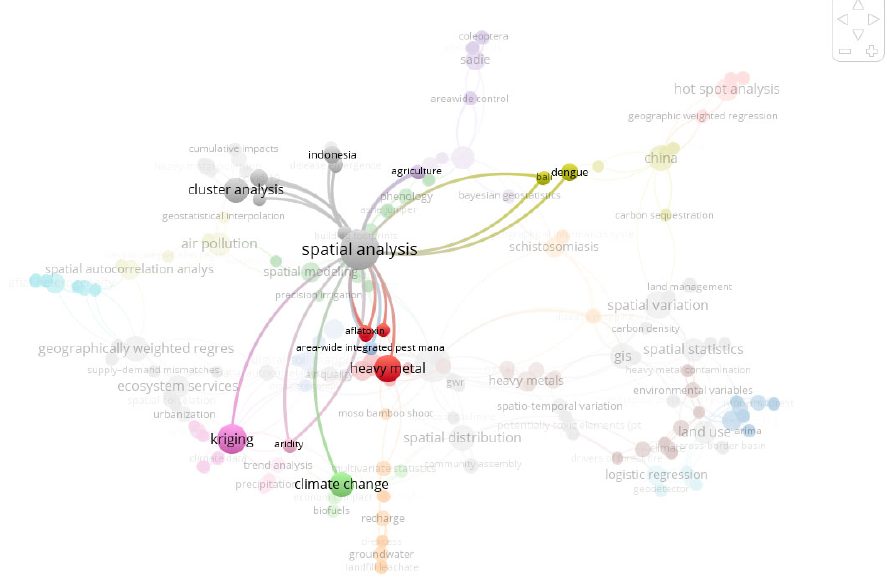
Fig. 4. Spatial Analysis model title and abstract network terms